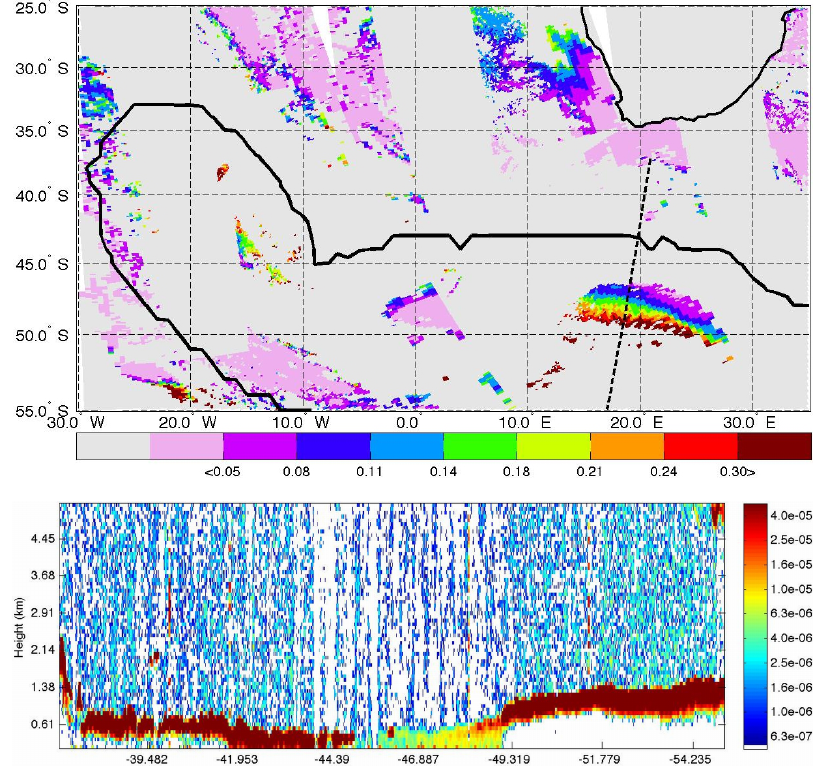
Fig. 12. Top: MODISAqua Aerosol optical depths for 3 March (around 13:25UTC) with the contour of dust concentration of constrained run Feb26TdF. The dashed line is the GLAS track for an overpass pass at 14:13UTC. Bottom: the backscattering profile for the track shown in the AOT image and shows that the high optical depths correspond to boundary level